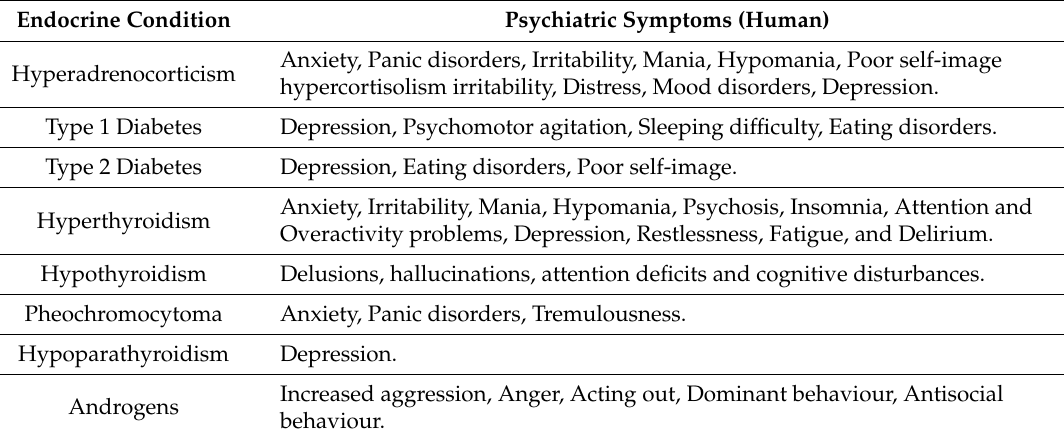
Table 1. Psychiatric signs associated with endocrine disease in human patients (after, Conner and Solomon